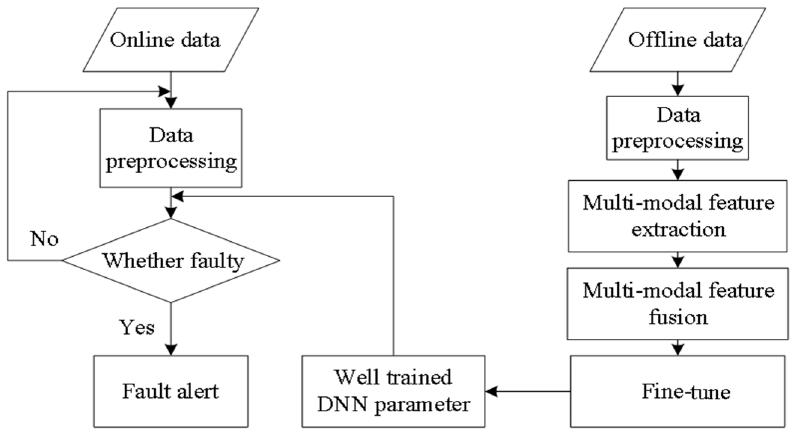
Figure 8. Differential geometric feature fusion-based DNN (DGFFDNN)-based diagnosis for frequency-type faults.